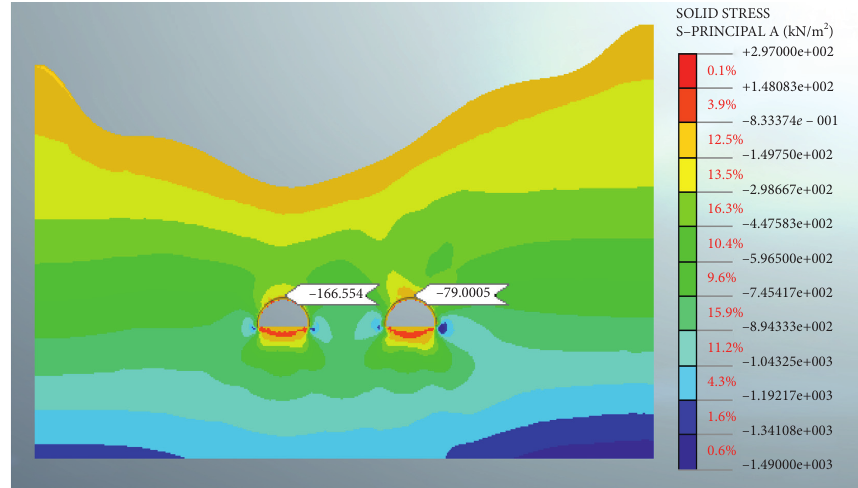
Figure 19: Small principal stress distribution of surrounding rocks in single-side guide pit method.